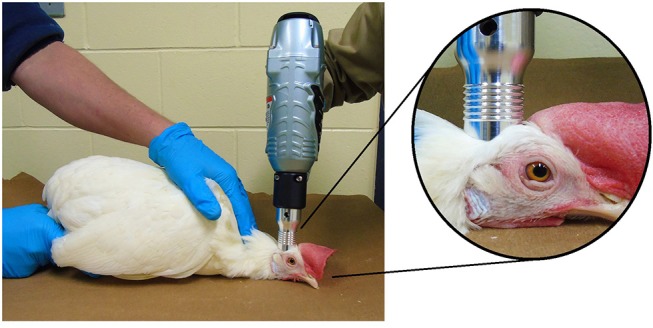
Application of the Zephyr-EXL device on a 30 w.o. hen: The bird was restrained in sternal recumbency with its neck resting ventrally on the ground, and the wings held gently toward the body during the application of the device. Device was placed perpendicular to the top of the frontal bone just behind the comb and on the mid line between the eyes and ears.